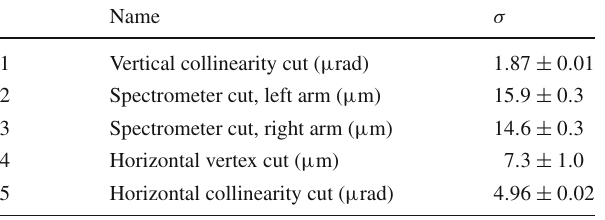
Table 1 The physics analysis cuts and their characteristic width σ for DS g in Diagonal 1 (the other diagonal agrees within the quoted uncer- tainty).Thewidth σ ofthehorizontalandverticalcollinearitycutsdefine the resolution in the scattering angle, see Fig. 2